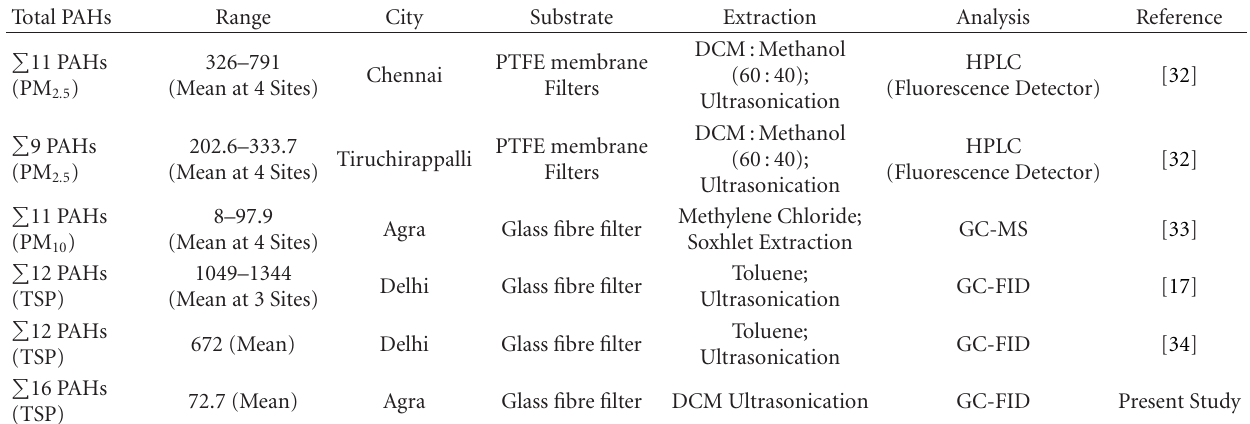
Table 2: Comparison of total PAHs (ngm − 3 ) with various cities of India.